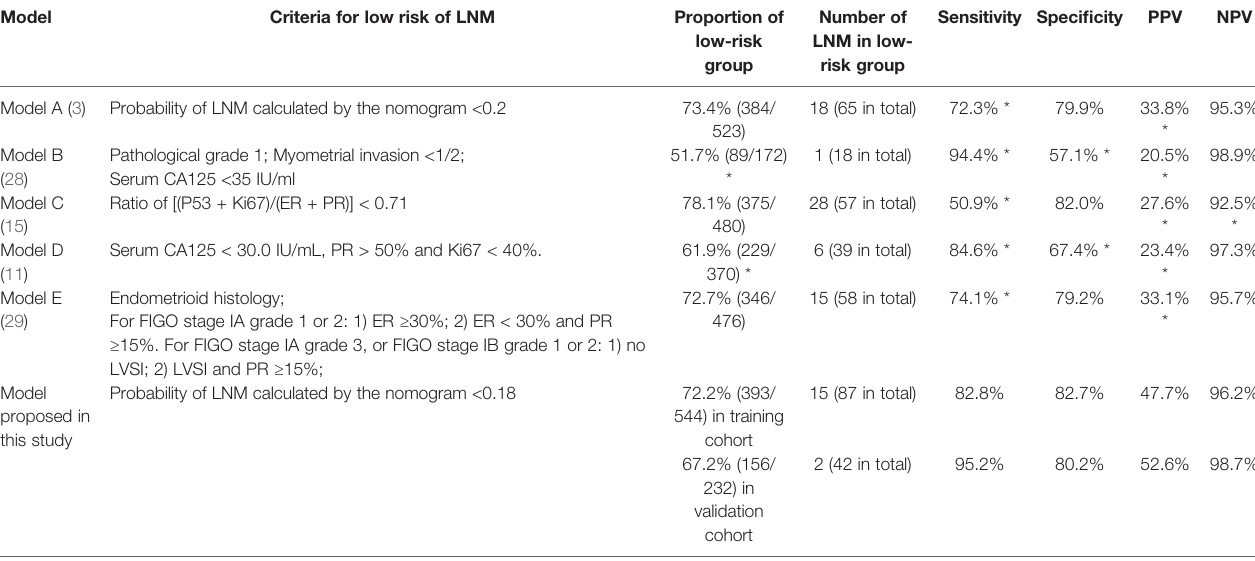
TABLE 4 | Discrimination of different models in their ability to distinguish patients with a low risk of LNM. Model Criteria for low risk of LNM Proportion of